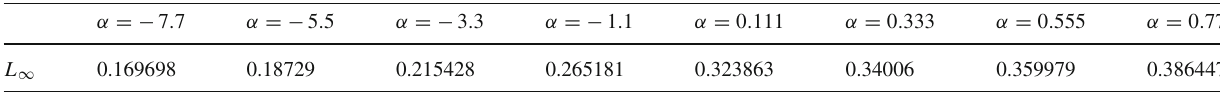
Fig. 4 The black hole shadows cast by static accretion for different α with M = 1 in the ( x , y ) plane. The bright ring is the photon sphere Table 2 The net luminosity of the escaping rays for different α with M = 1 α = − 7 .